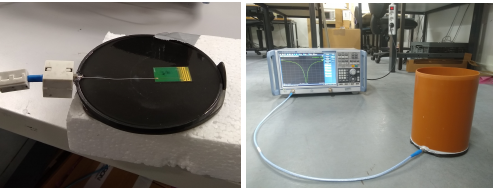
Figure 5. The embedded antenna in the epoxy disk representing the hoof pad connected to the VNA with an SMA-X.FL adaptor and the full setup on the